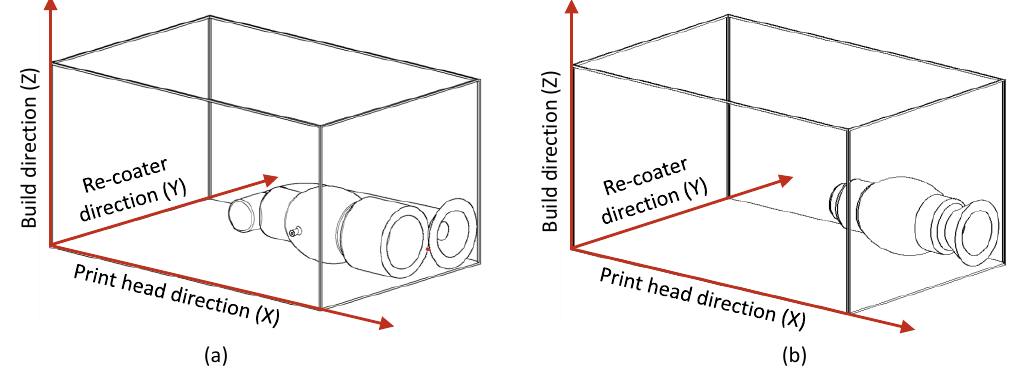
Figure 3. Positioning of the moulds on the machine table related to the axes of the AM ProJet 660Pro machine. ( a ) Gravity-pouring mould. ( b ) Vacuum-assisted mould.